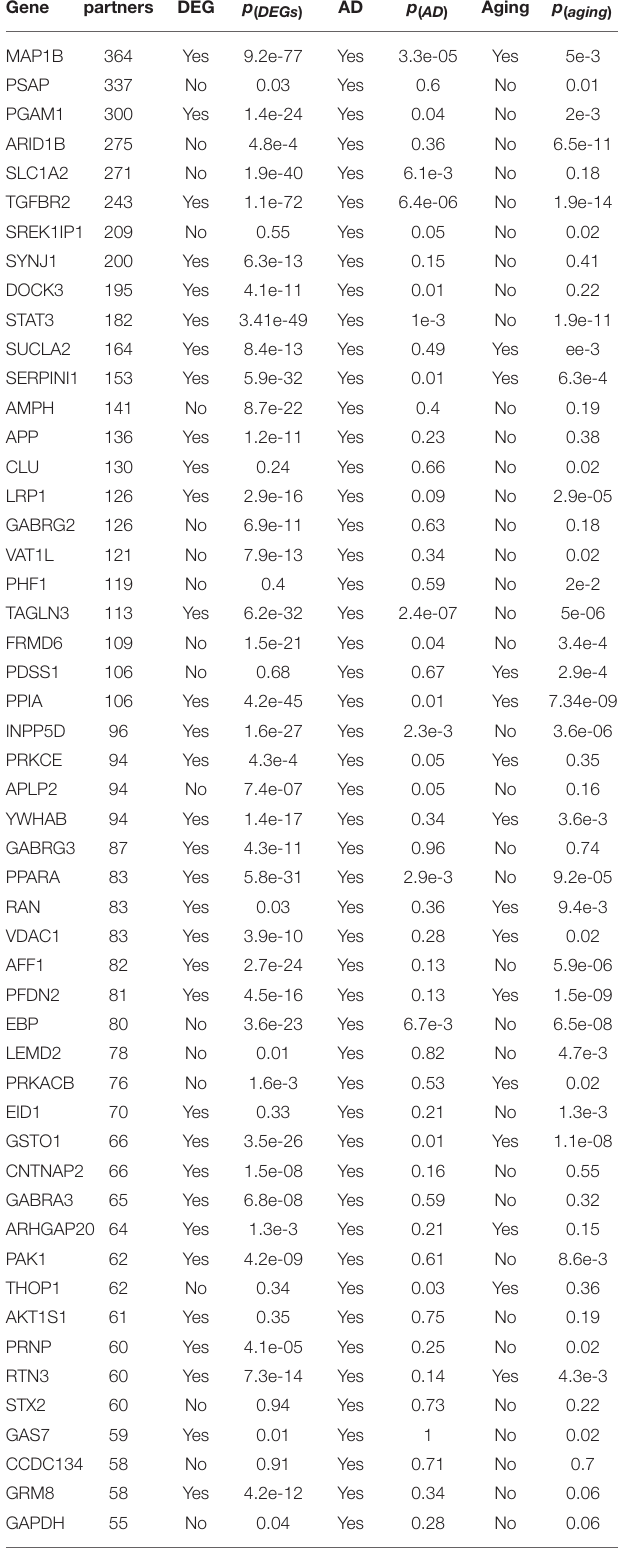
TABLE 1 | The dysregulated AD